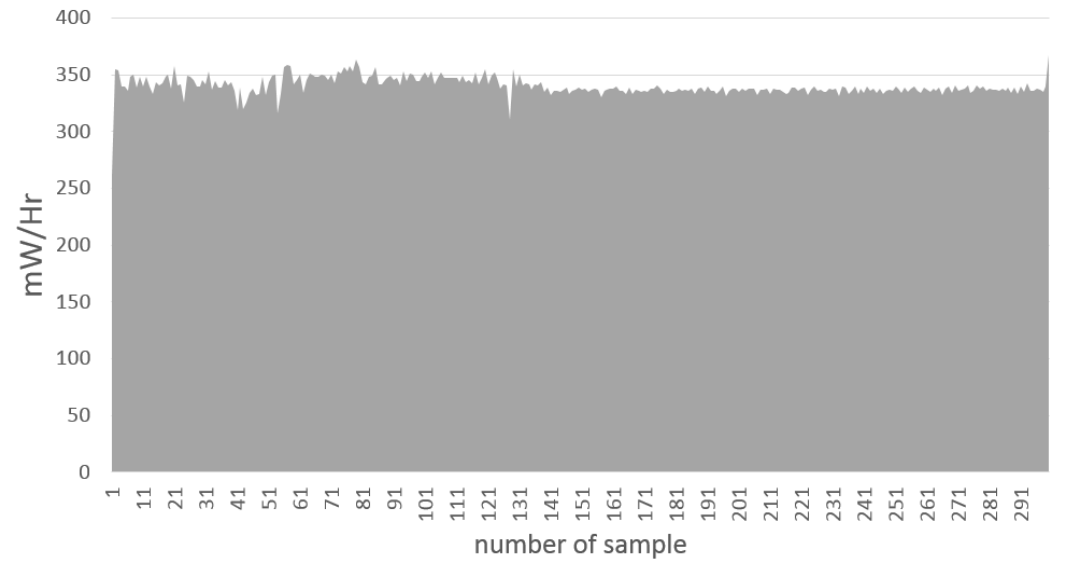
Figure 15. Example of power consumption area chart. Table 11. Battery consumption of the implemented method per the evaluation of rules (estimation of